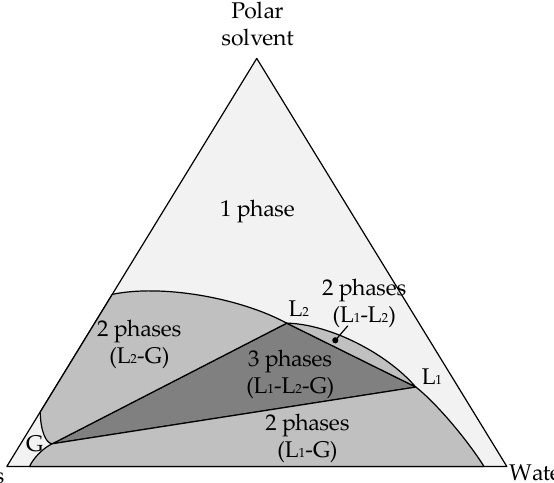
Figure 1. Typical phase diagram for “gas–water–polar solvent” systems at high pressure [43].